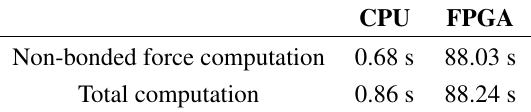
Table 2. Comparison of the processing time using the straight forward method by using the same software code used in CPU implementation.